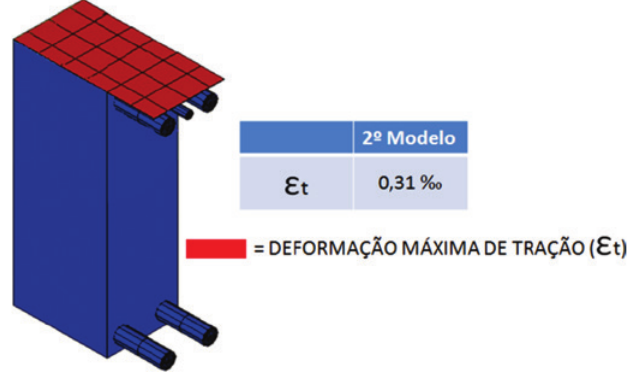
Figura 14 Deformações no PRFC na seção de momento máximo